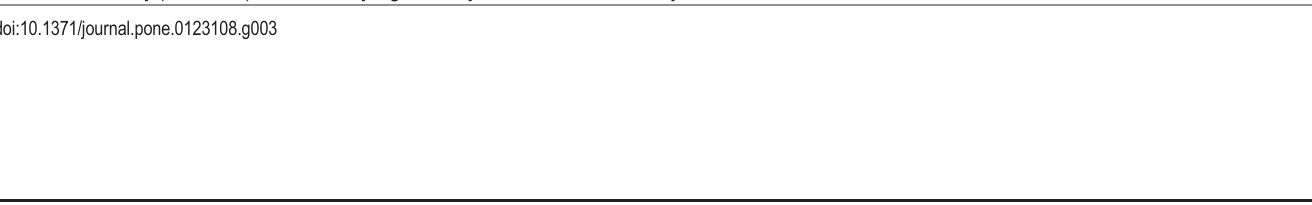
PLOS ONE | DOI:10.1371/journal.pone.0123108 April 2,